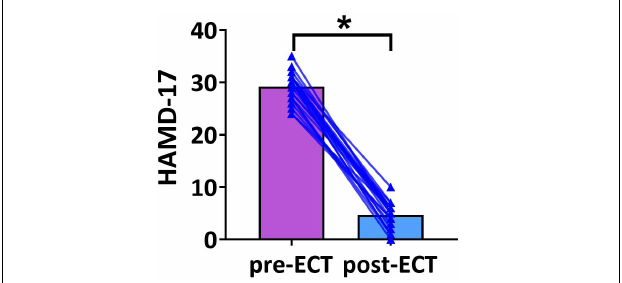
FIGURE 1 | The Hamilton Depression Rating Scale-17 (HAMD-17) scores of pre- and post-ECT patients with MDD. The bar chart represents the mean values of HAMD-17 scores in pre- and post-ECT treatments. The * indicates a significant difference ( p <